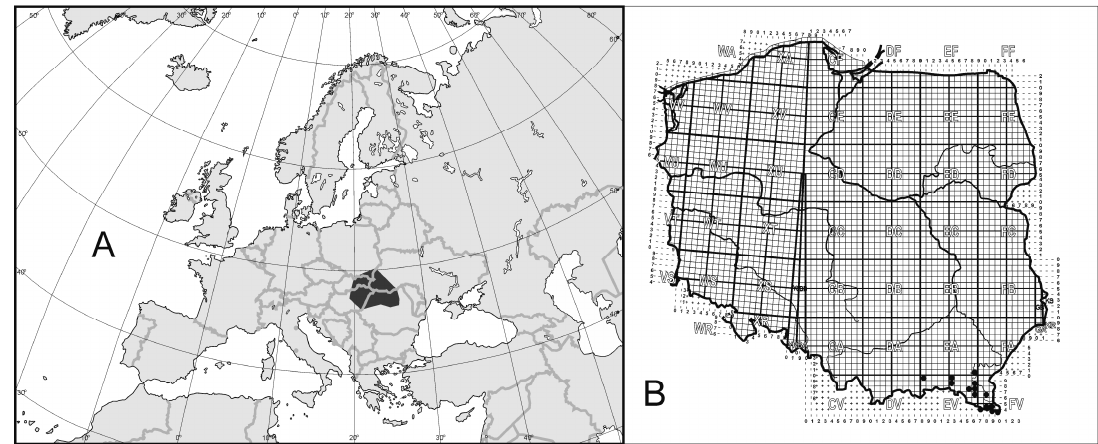
Figure 5. Range of Urodiaspis stammeri : ( A ) in Europe, ( B ) in Poland; black dots—recorded occurences of the species.